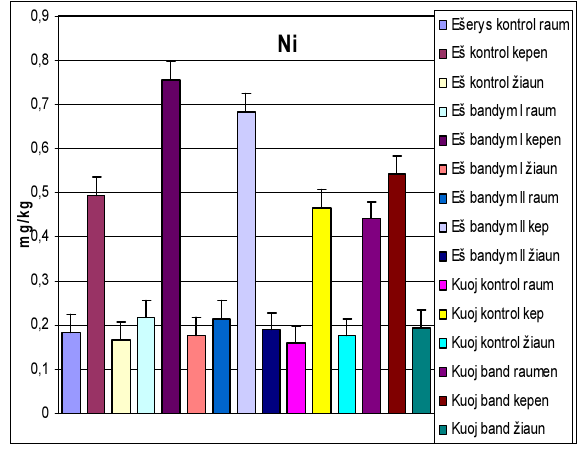
Fig. 7. Heavy metal concentrations (mg/kg) in fish tissues from water contaminated with nickel in 2005